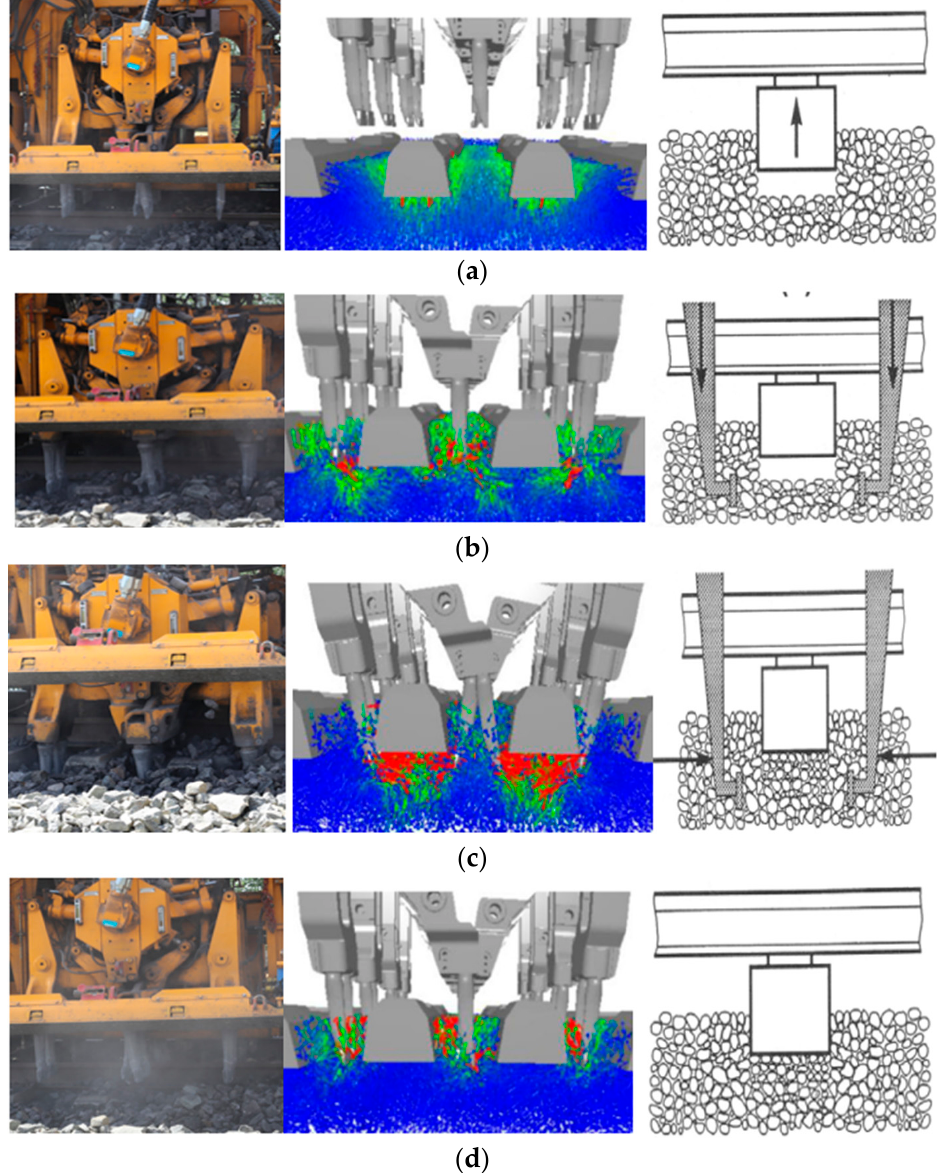
Figure 5. Illustration of the four stages of each cycle of tamping operation: ( a ) Sleeper-lifting stage; ( b ) Tine-inserting stage; ( c ) Ballast-squeezing stage; and ( d ) Tine-retracting stage.